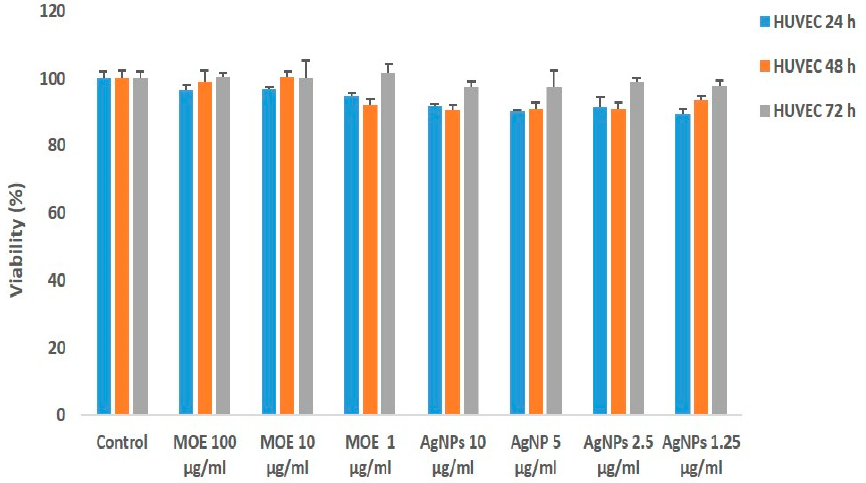
Figure 5. Cytotoxic effect of biosynthesized silver nanoparticles (AgNPs) and M. oleifera extract (MOE) on cell viability of HUVEC cell line.